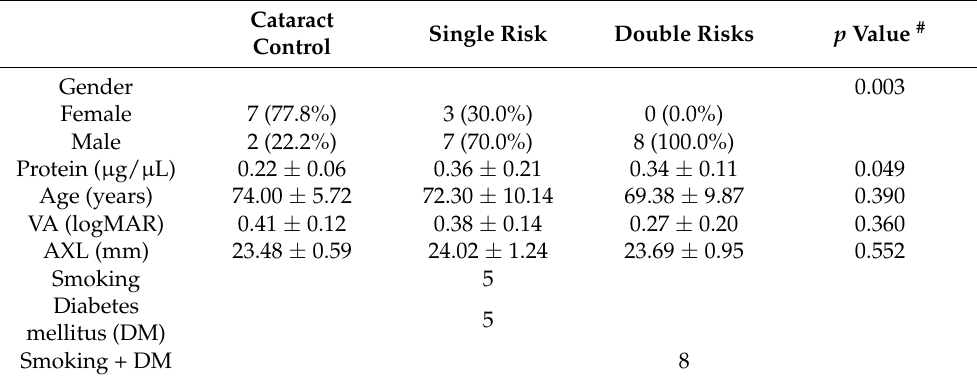
Table 1. Demographic characteristics of enrolled patients with a single risk factor, those with Double risk factors, and cataract